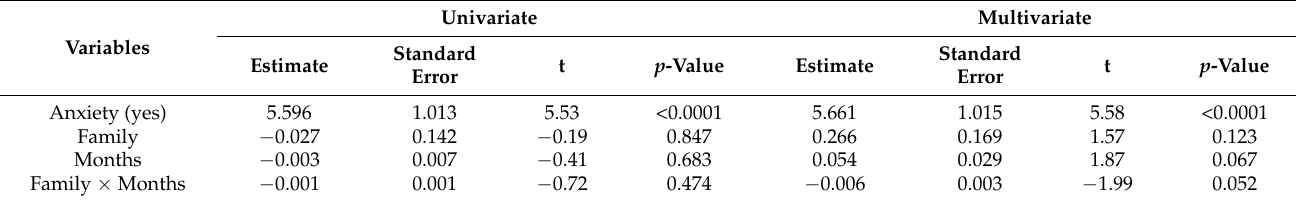
Table 4. Regression analysis of